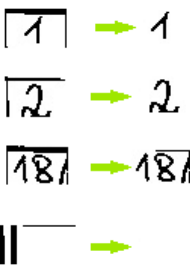
Figure 3. Effect of contour cleaning.